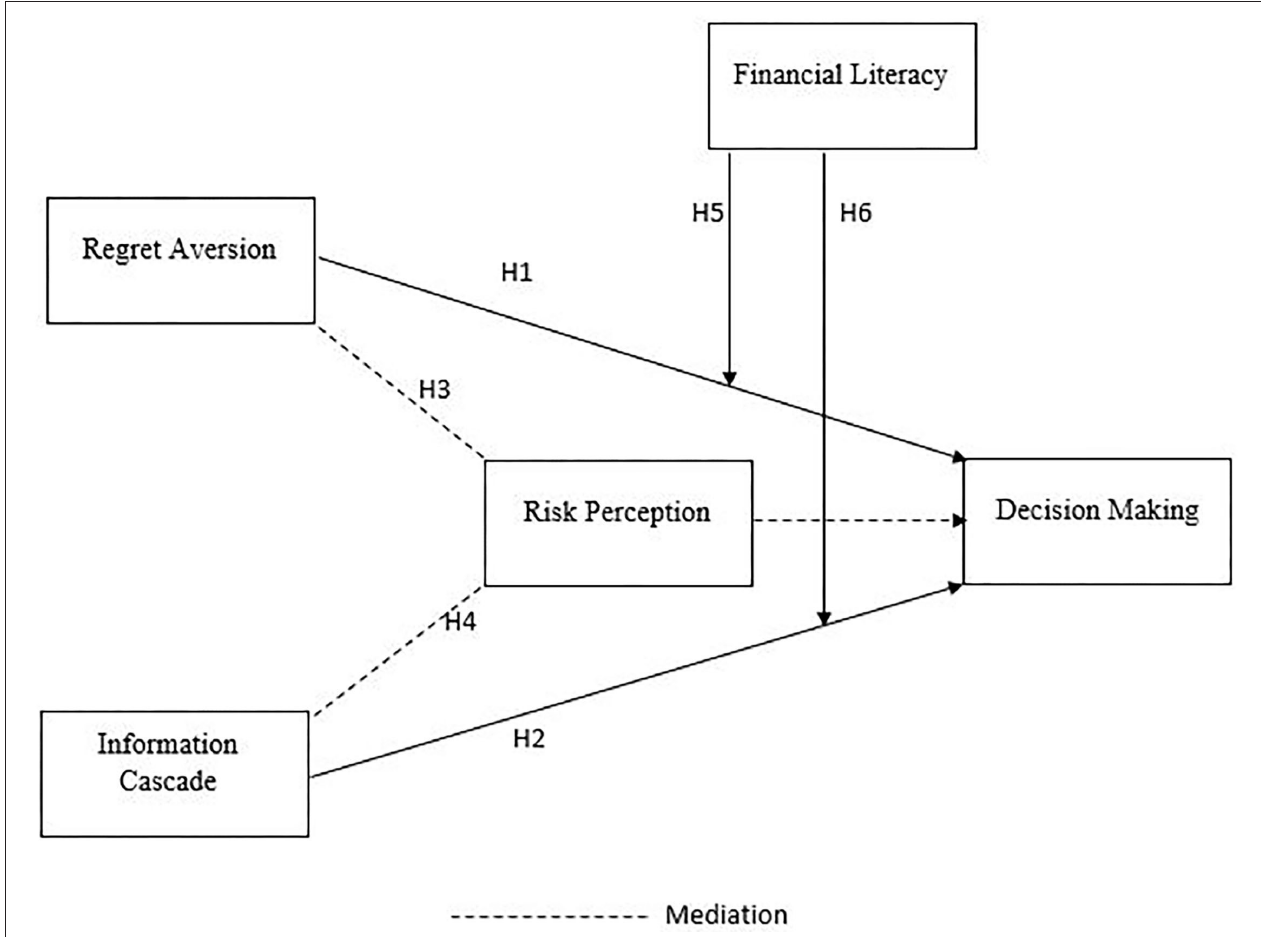
FIGURE 1 | Conceptual